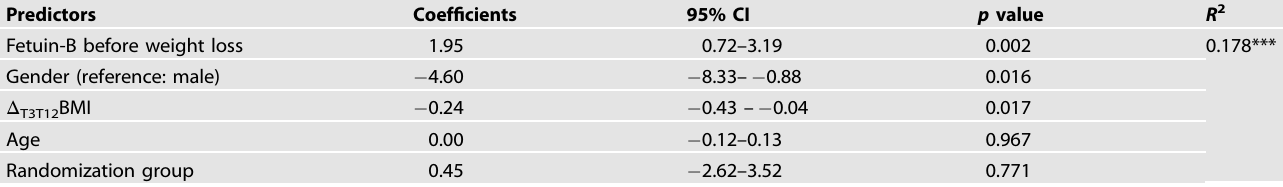
Table 4. Prediction of long-term improvement of insulin-mediated suppression of FFAs between T-3 and T12 ( Δ T3T12 FFA Supp ) by baseline Fetuin-B level, gender, and concomitant change of BMI.